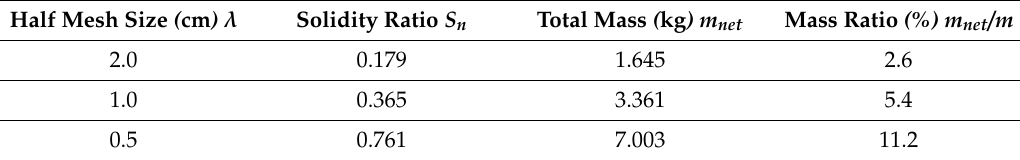
Table 2. Numerical model test